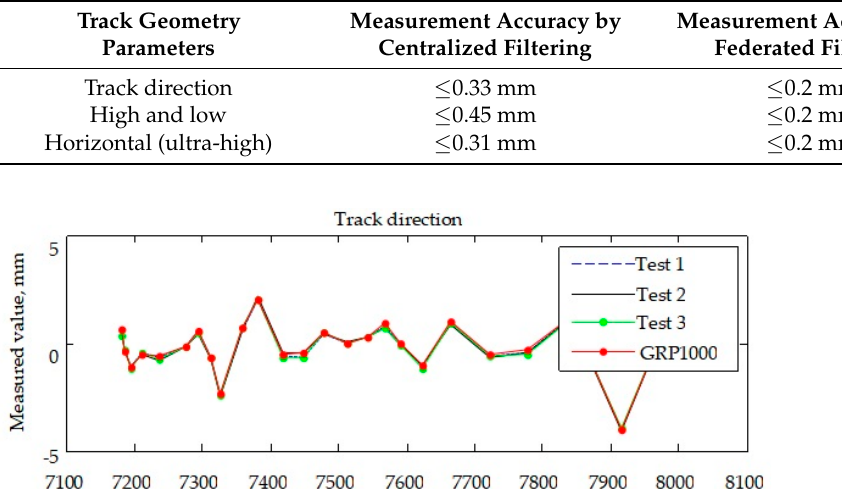
Table 2. Comparison of measurement accuracy of different filtering methods.